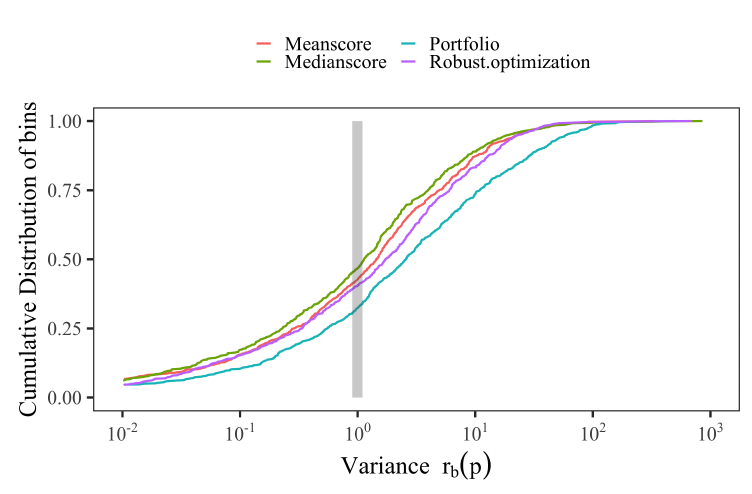
( p ) = ( f b ( p ) − R b ) 2 . b ∆ f ( p ) 2 + ∆ R 2 b b